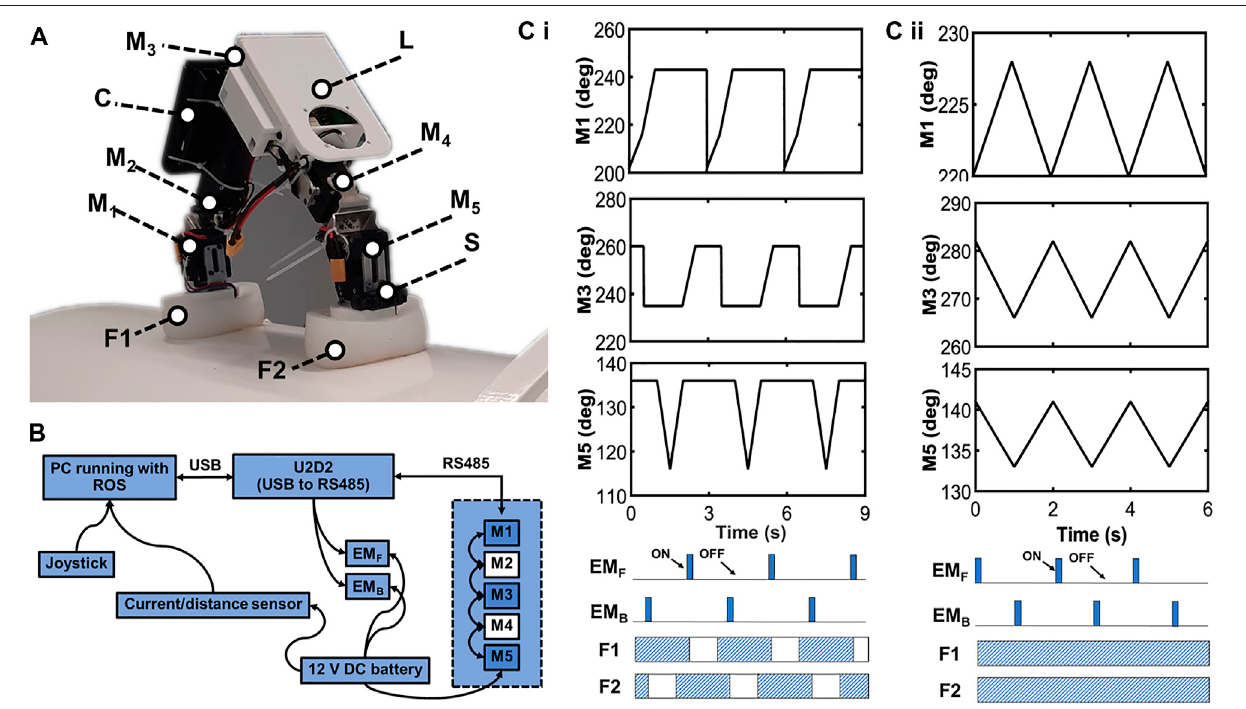
FIGURE 10 | An overview of the inchworm-inspired crawling robot. (A) The labeled photograph of the robot standing on a metal pipe. Here, M 1,2,3,4,5 denote the fi ve servo motors; S is the IR distance sensor; C is the control board holder; L is the additional payload space, or alternatively a lifting mechanism, and F softrobotfeet. (B) Therobotsystemdiagram.TheM 2,4 servomotorswerekeptlockedtoallowtheothermotorstobecontrolledforunidirectionalrobotmovement. (C,i) Therobotmotorsignalsfortheunidirectional steppinggait ,magnetswitchingdiagram,andresultinggaitpattern. (C,ii) Therobotmotorsignalsfortheunidirectional sliding gait , magnet switching diagram, and resulting gait pattern. Gait generation is achieved by state-machine control (see Khan et al. (2020) for